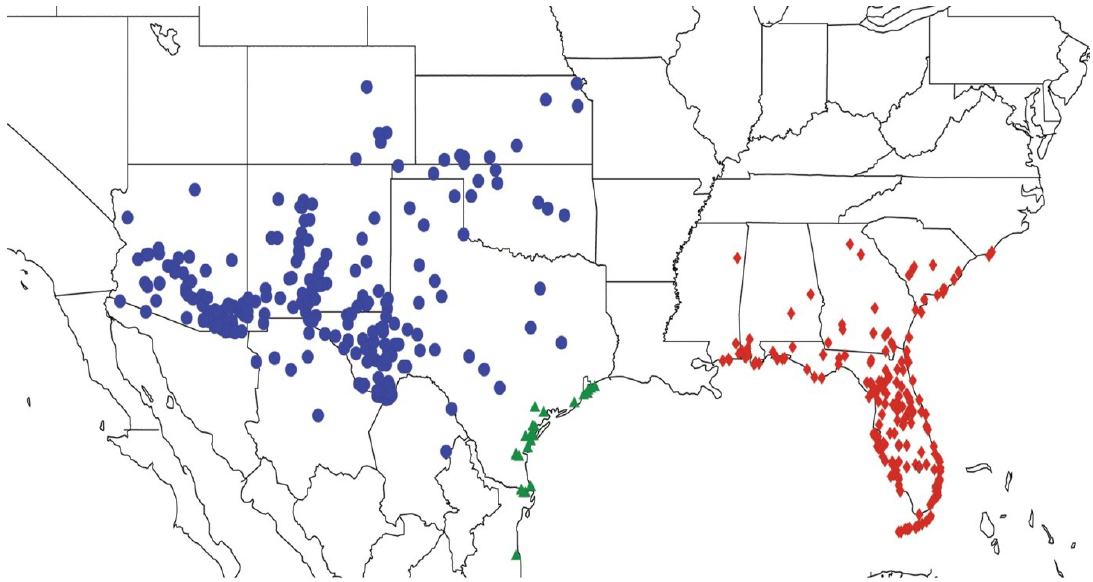
Figure 8. Distribution of Dicerprocta eugraphica (blue circles), D. marevagans (green triangles) and D. olympusa (red